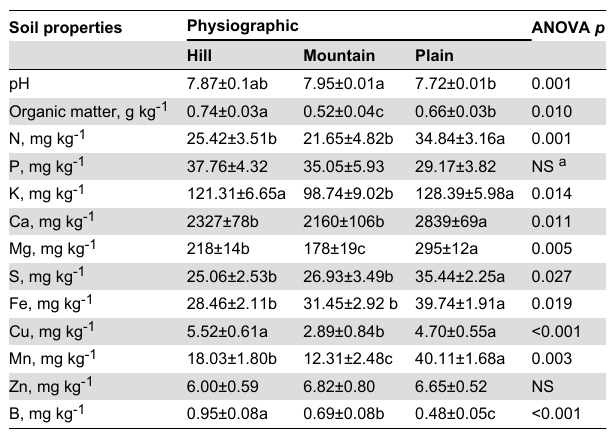
Table 6. Mean surface soil properties (0–20 cm) for topography types (hill, n =126; mountain, n =120; plain, n